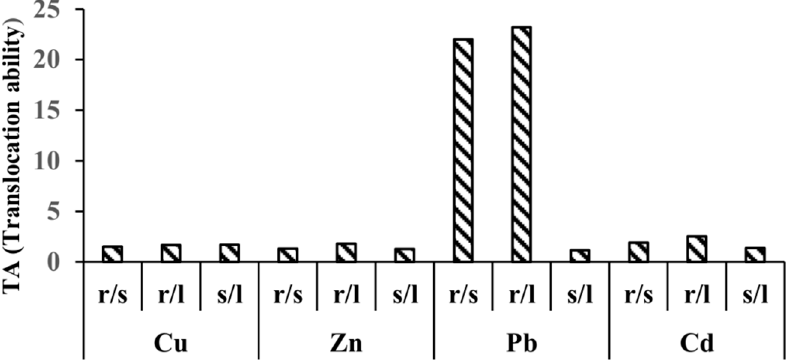
Figure 3. ranslocation ability(TA root/stem; root/leaf; stem/leaf ) for Cu, Zn, Cd and Pb. Figure 3. Ranslocation ability(TA root / stem; root / leaf; stem / leaf ) for Cu, Zn, Cd and Pb.